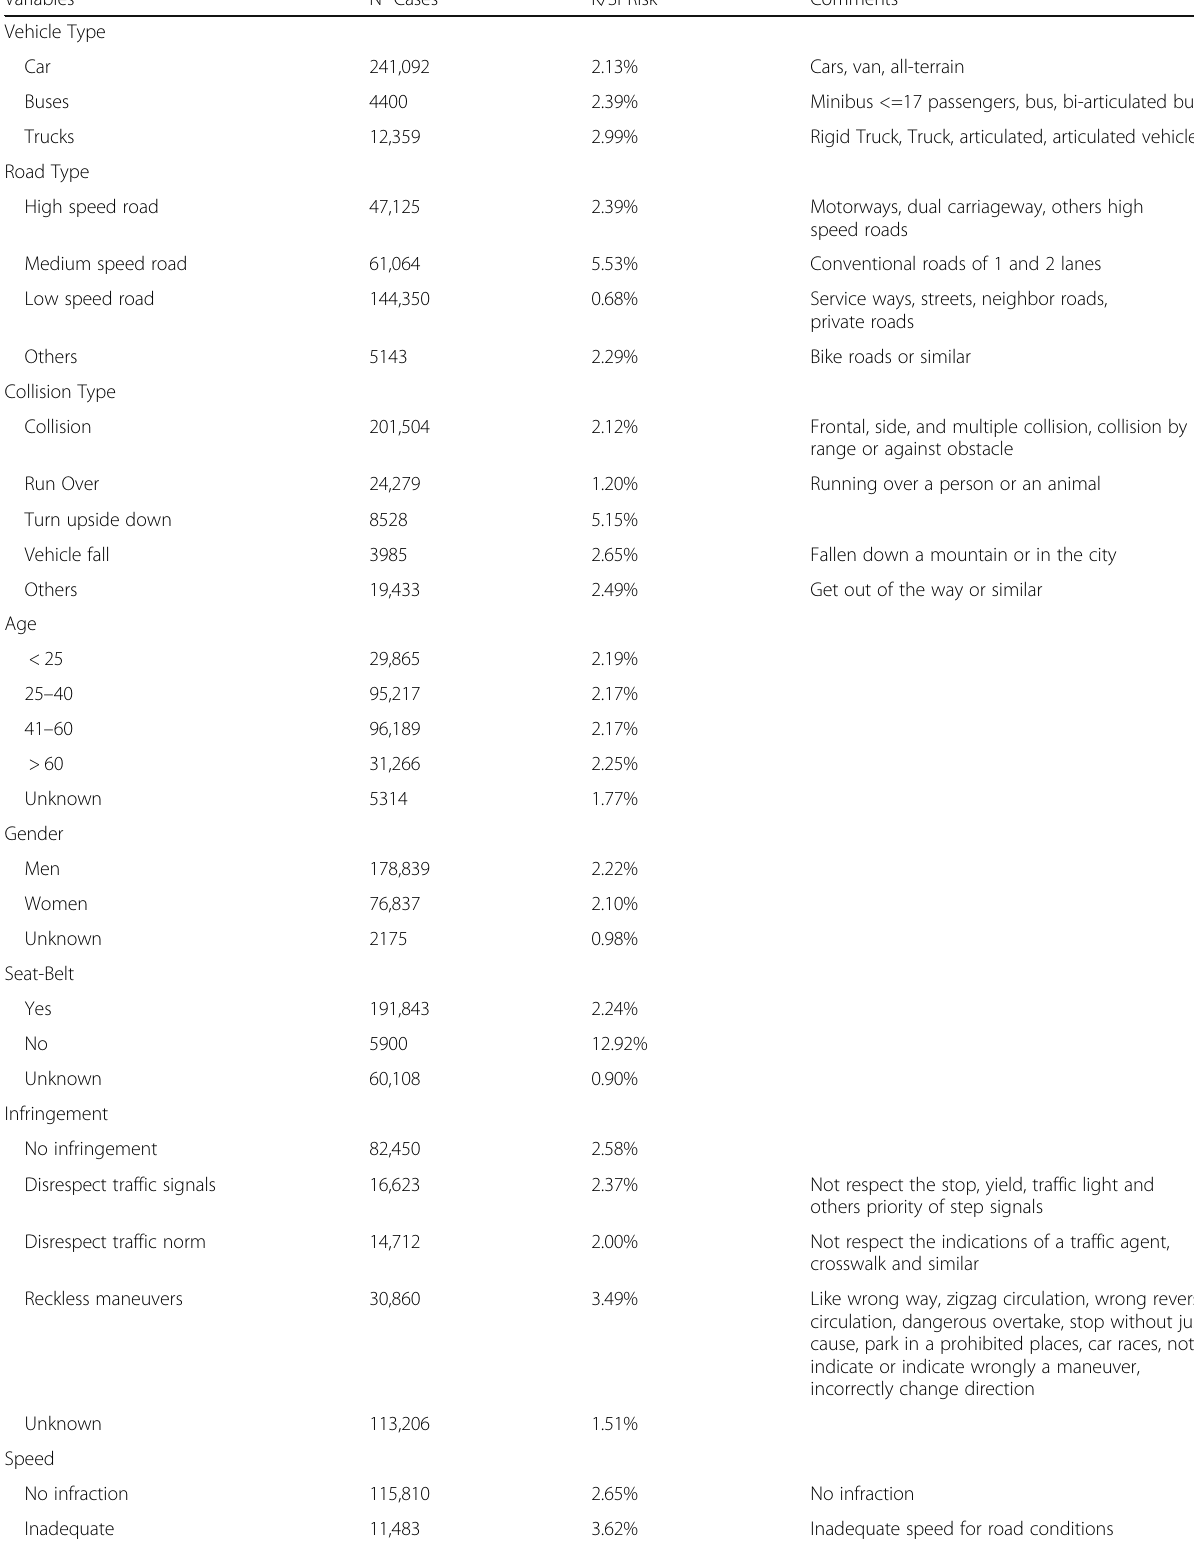
Table 3 A priori probability of the severity of the injury. Processed by the